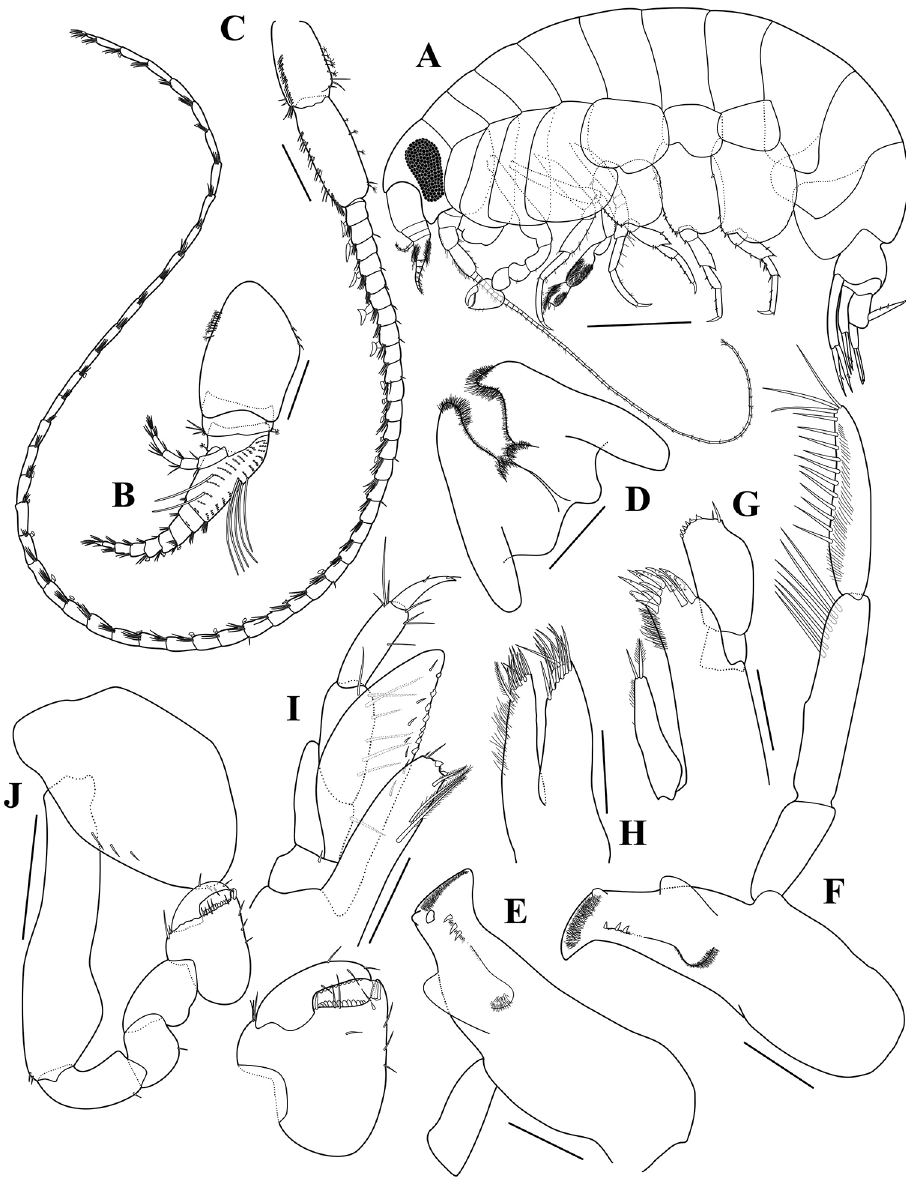
Figure 2. Opisa parvimana sp. nov. holotype, adult male, MARBK-300, 8.3 mm A habitus B antenna 1 C antenna 2 D lower lip E left mandible F right mandible G maxilla 1 H maxilla 2 I maxilliped J gna- thopod 1. Scale bars: 1.0 mm ( A ), 0.2 mm ( B, C ), 0.1 mm ( D–I ), 0.4 mm ( J ). chium short, 0.19× basis, with 2 unequal simple setae posterodistally; merus subequal in length to carpus, slightly produced anterodistally, with 1 simple seta anterodistally and 6 unequal simple setae; carpus subrectangular, with 1 simple seta